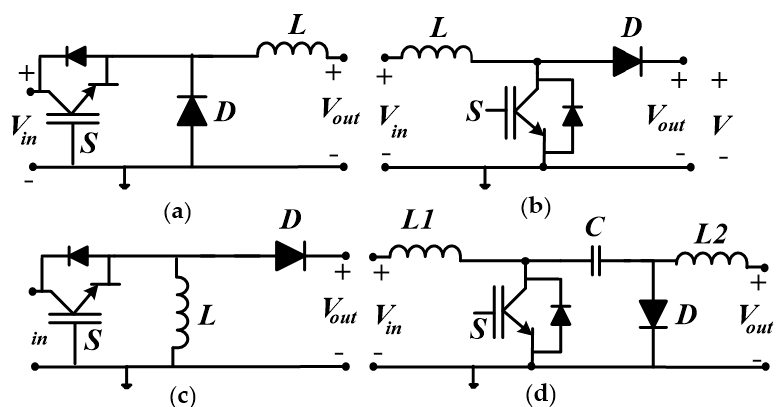
Figure 30. Numerous conventional non-isolated DC-DC converters: ( a ) buck, ( b ) boost, boost, and ( d ) Cuk ( c ) buck–boost, and ( d ) Cuk [134].